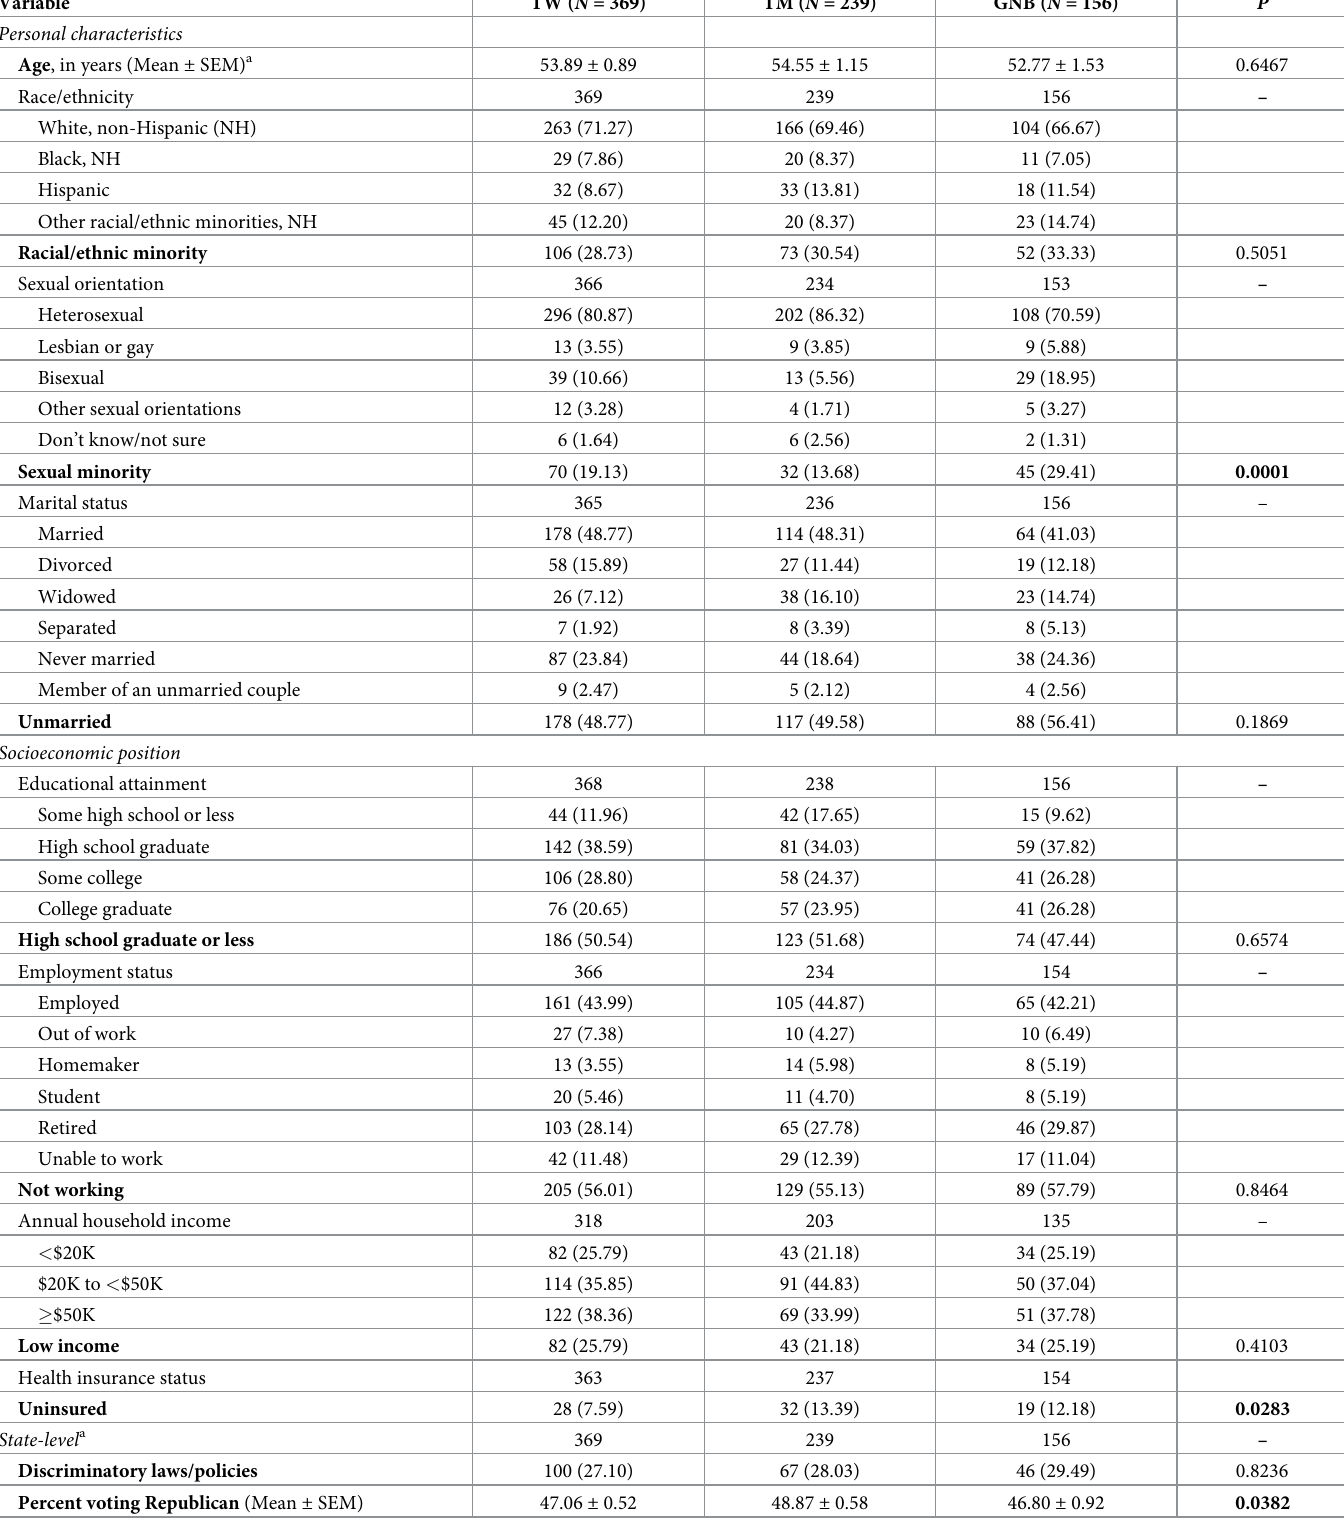
Table 2. Bivariate model results: Study group, individual and state-level factors, and